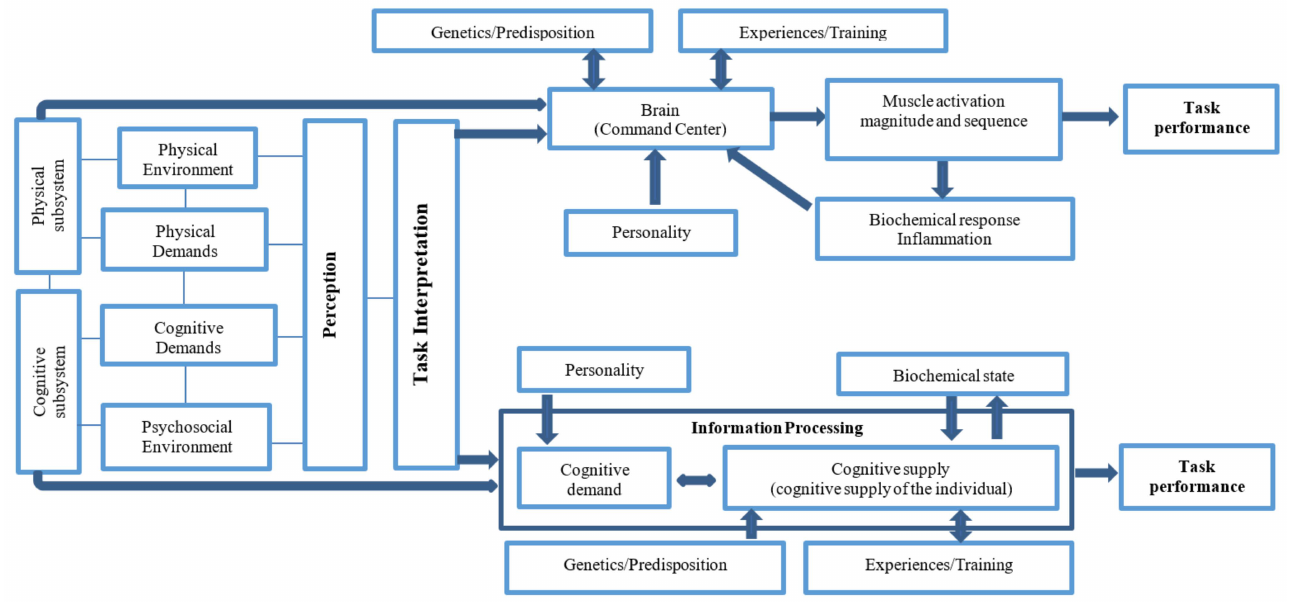
Figure 5. Interrelation between the physical and cognitive subsystems. Adapted from